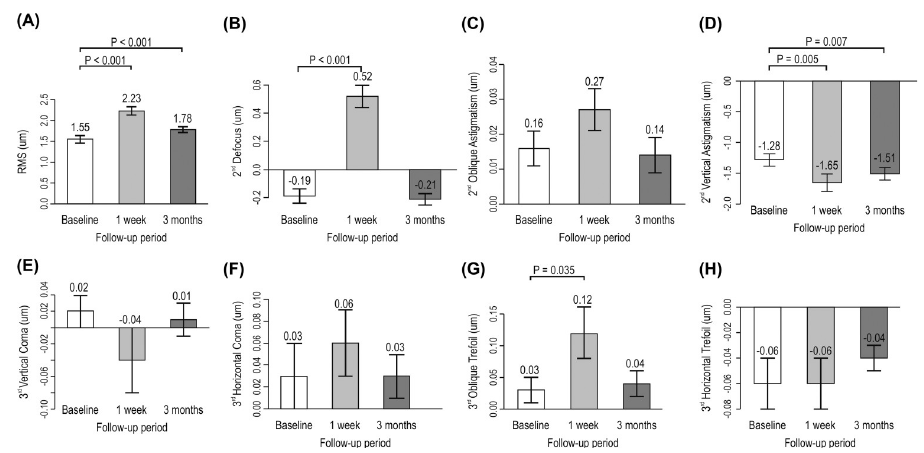
Fig 2. Change in RMS ( μ m), second- and third-order aberration ( μ m) according to follow-up time. Data expressed as mean ± standard error. RMS: root mean square.